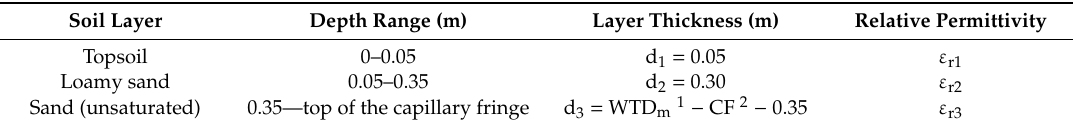
Table 1. Details of di ff erent soil